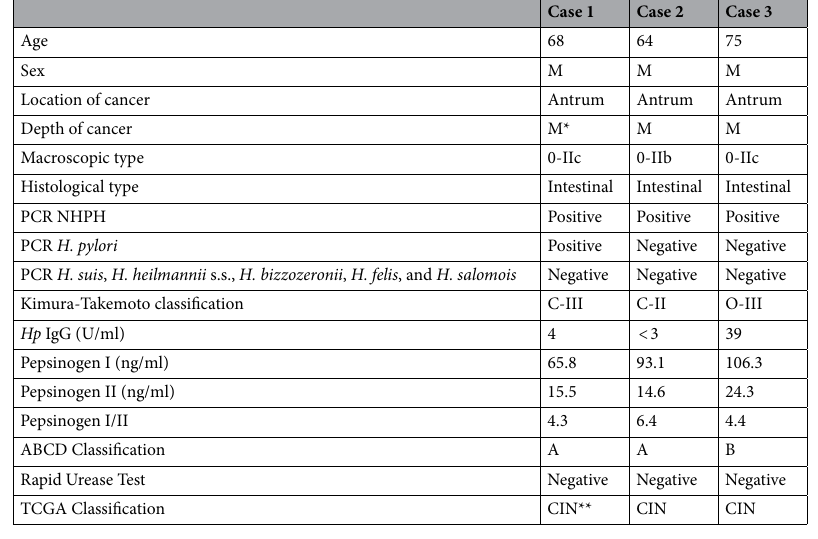
Table 2. NHPH related characteristics of the 3 patients. *Depth M is confining to mucosa. **CIN is Clomosomal Instability